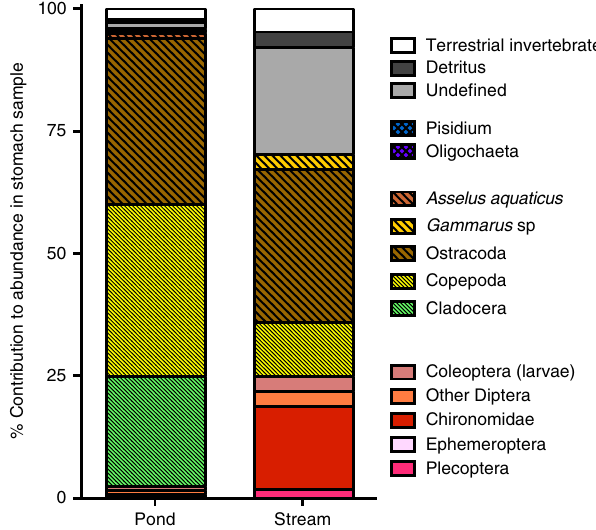
Figure 2 | Food consumption differs between larvae from different habitats. Proportional abundance of items in the stomach contents of pond and stream larvae sampled in the field survey. Sample sizes were: n ¼ 46 (streams); n ¼ 31 (ponds).